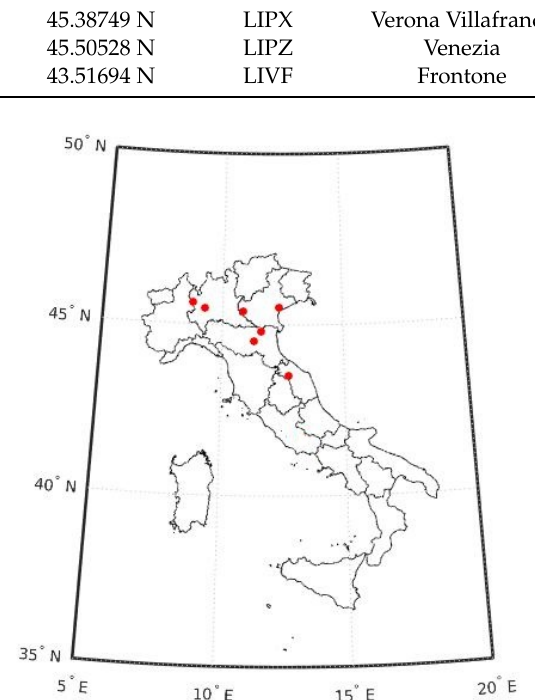
Figure 4. Map position of the seven sites selected for fog forecast.